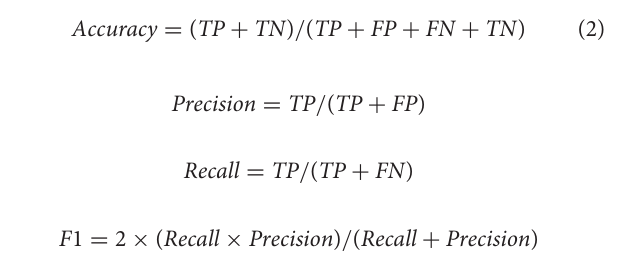
TABLE 5 | The F-Score of facial micro-expression recognition when the window size is 20 frames around the apex frame or 60 frames. Arousal Valence Window size 20 60 20 60 DEAP 55.0 59.0 55.7 56.8 Experimental 61.0 62.2 57.0 61.1 The bolded values show the highest F-scores for each dataset and emotional level according to the window size. Increasing the window size to 60 frames increase the